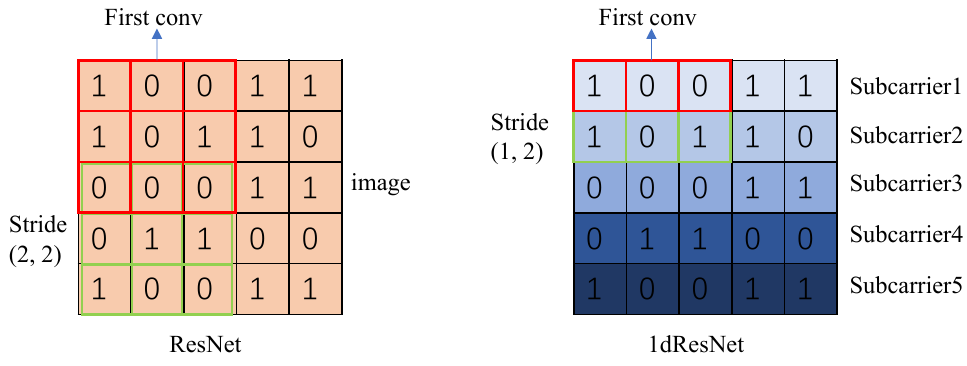
Figure 6. ResNet is usually used to extract the features of RGB images. There is a large amount of local information in the images, but each line of OFDM signal represents a subcarrier with timing information inside. Therefore, it is more reasonable to use 1-dimensional convolution and adjust the step size in OFDM